Question: What style of plot is this figure drawn as?
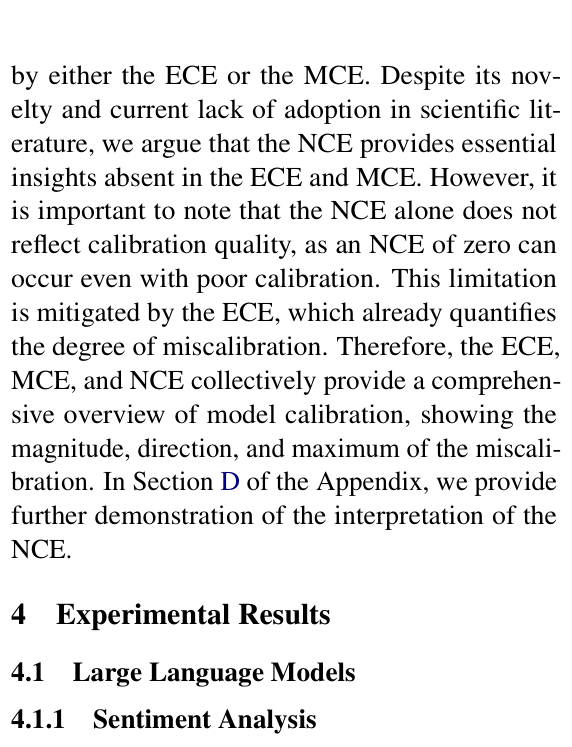
Answer: histogram